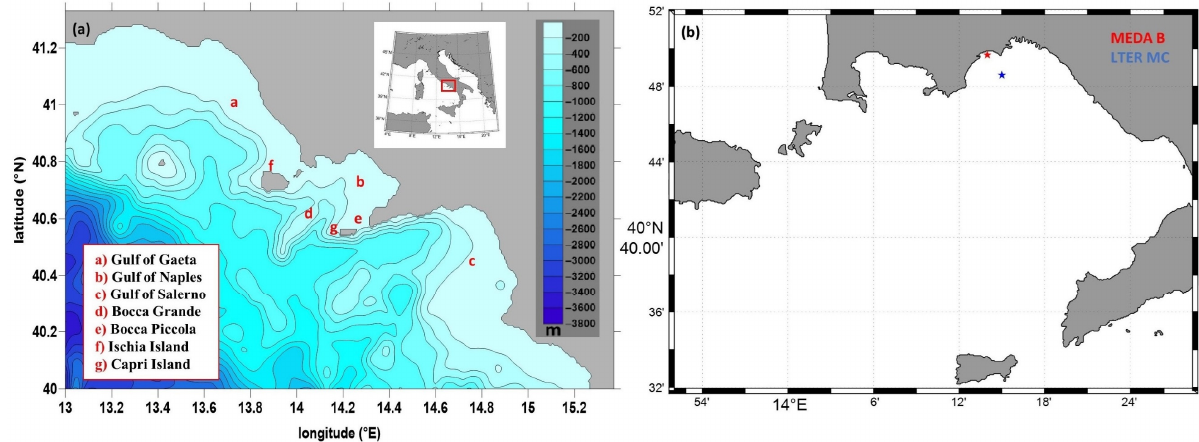
Figure 1. CROM bathymetry and domain ( a ). The GN ( b ) with the MEDA B Napoli buoy location (red star) and the LTER ‐ MC sampling site (blue star).